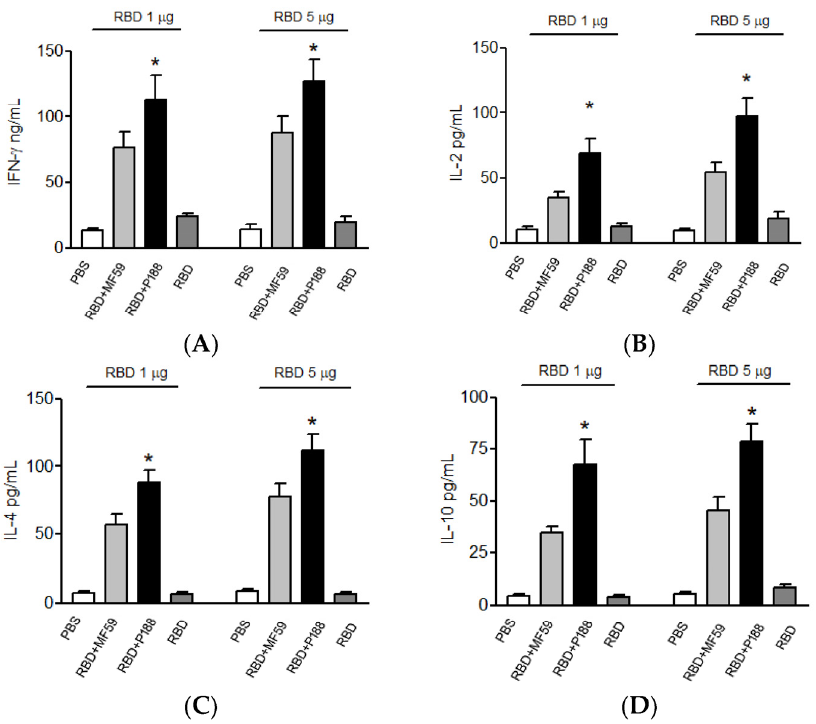
Figure 4. P188 up-regulated IFN- γ , IL-2, IL-10, and IL-4 in plasma of vaccinated mice compared with MF59. Plasma ( A ) IFN- γ , ( B ) IL-2, ( C ) IL-10, and ( D ) IL-4 from mice with PBS (as control), RBD plus MF59 (or P188) vaccination, and RBD alone vaccination were detected by ELISA. All results were presented as mean ± SD. * p < 0.05 vs. the RBD group and RBD + MF59